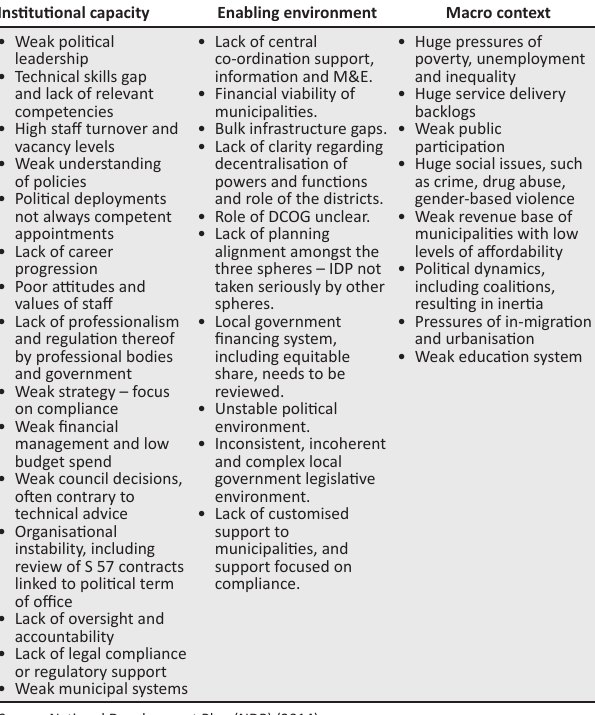
TABLE 1: Local government constraints.